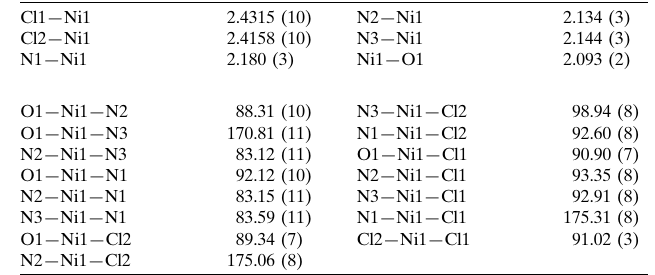
Selected geometric parameters (A˚ , (cid:3) ).